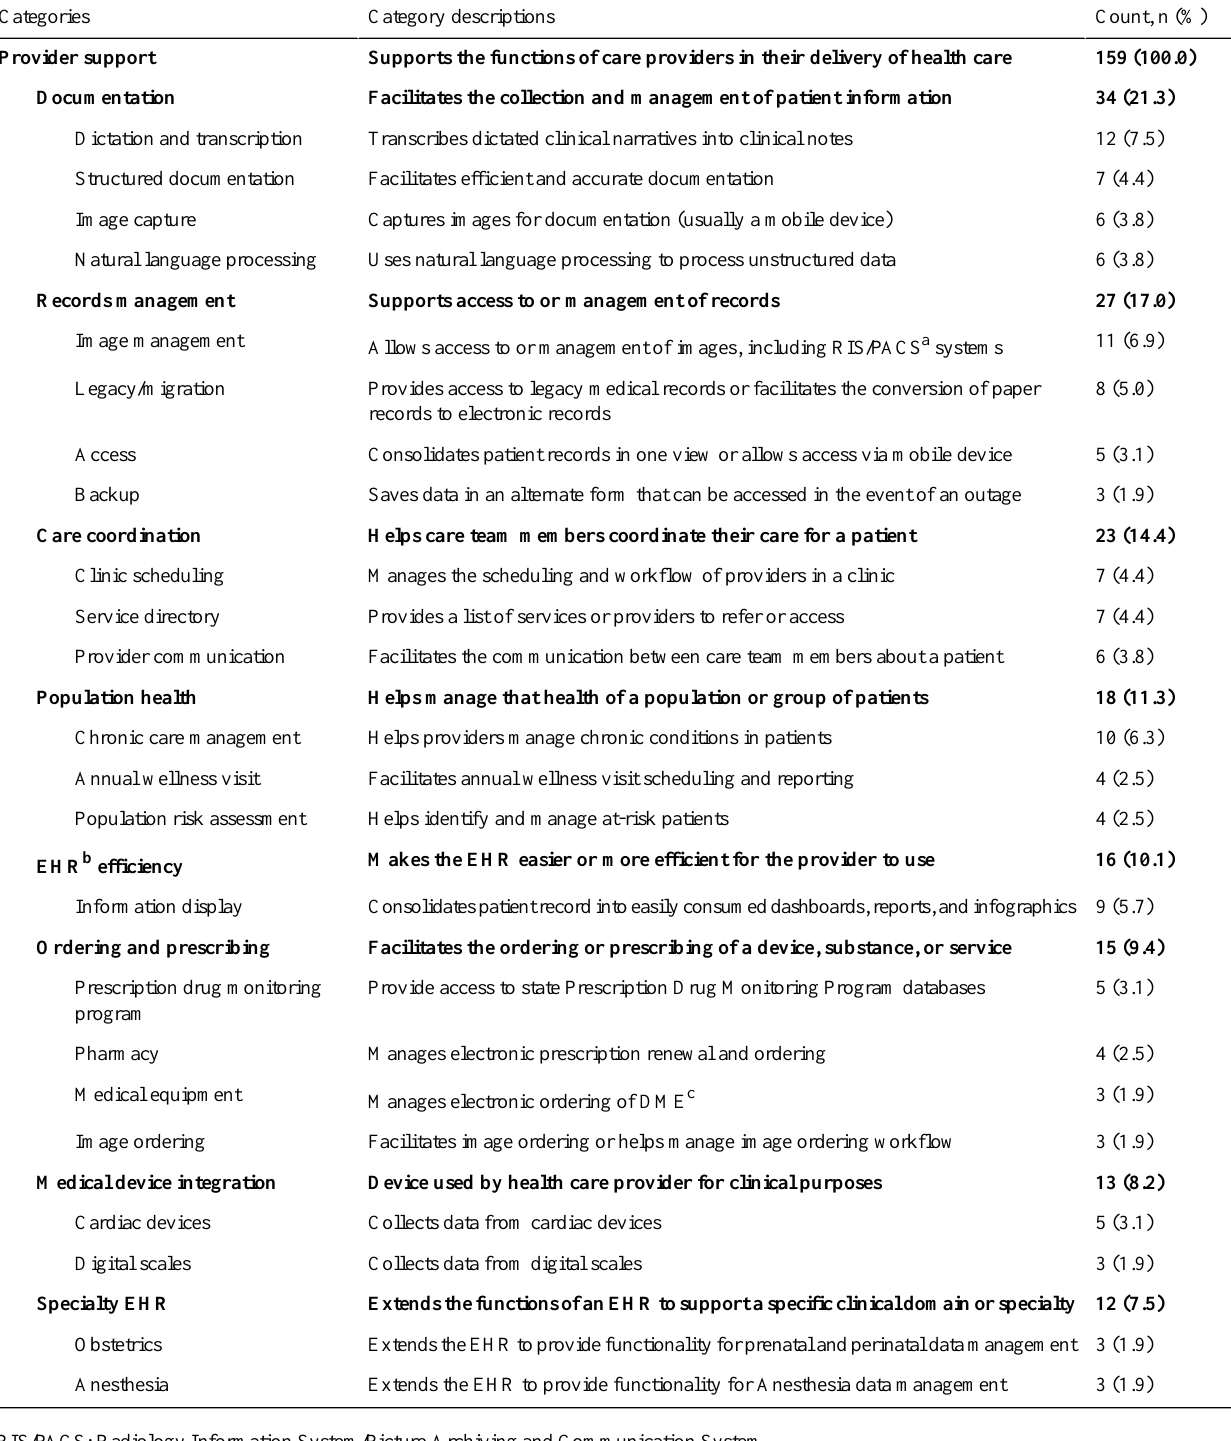
Table 3. Category definitions and counts for provider support apps (n=159).